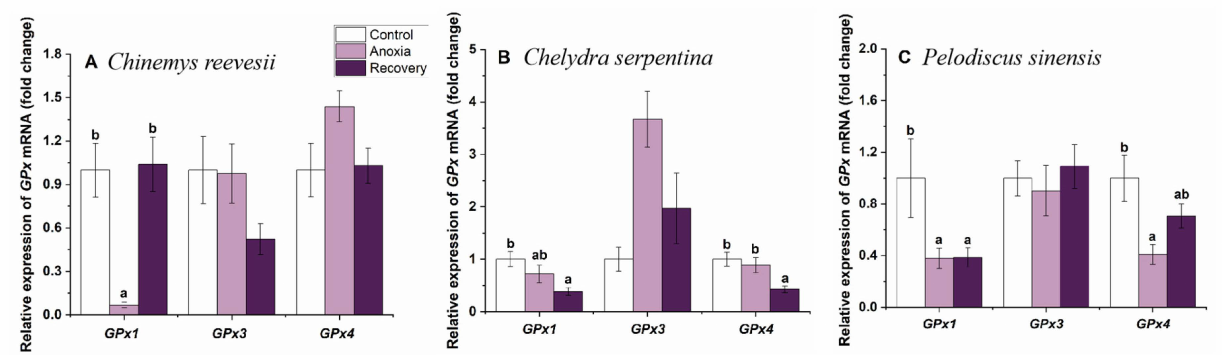
Figure 6. Changes of anoxia stress on related expression of GPx mRNA in the brain of C. reevesii ( A ), C. serpentina ( B ) and P. sinensis ( C ). Data are presented as mean ± SE. N = 8. Data with no common lowercase letters on the bar indicate significant differences between different groups ( p < 0.05).